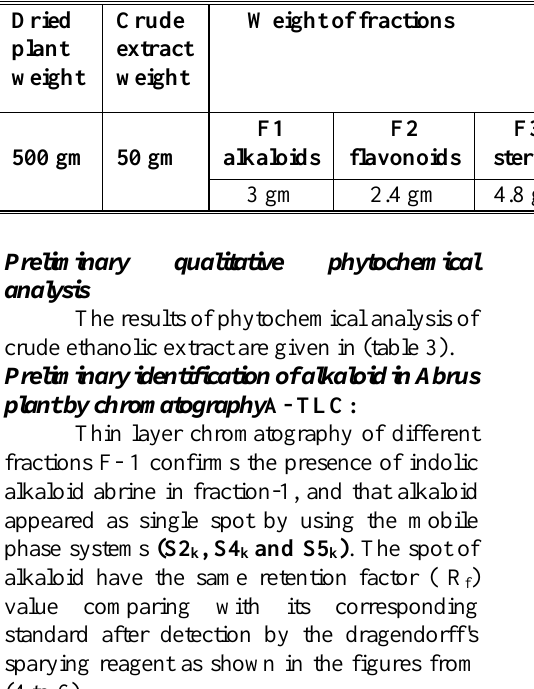
Table 2. Percentage of different fractions obtained from plant extraction of Abrus precatorius L.